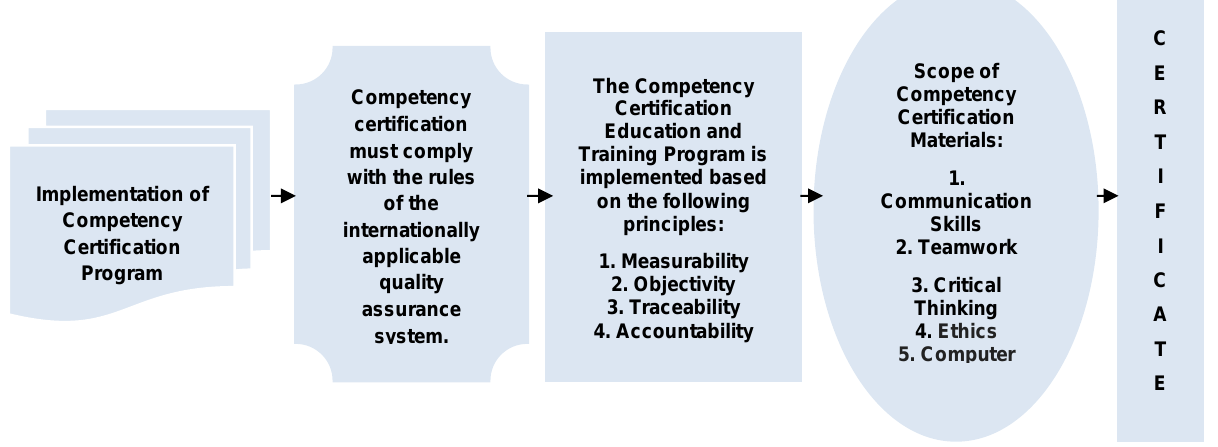
Figure 6. The Implementation of the Competency Certification